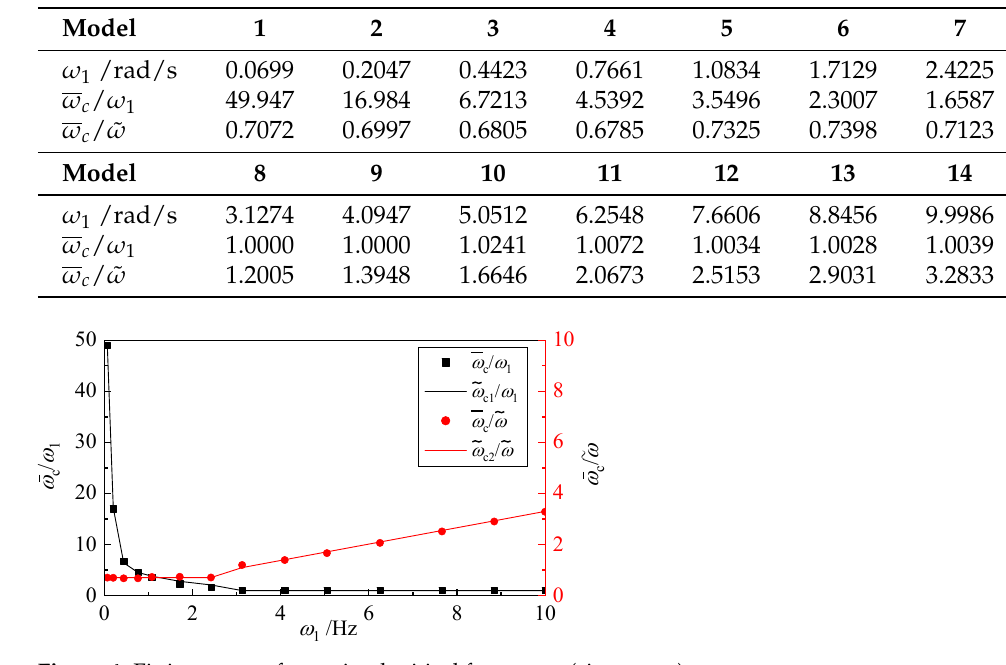
Figure 4. Fitting curves for optimal critical frequency